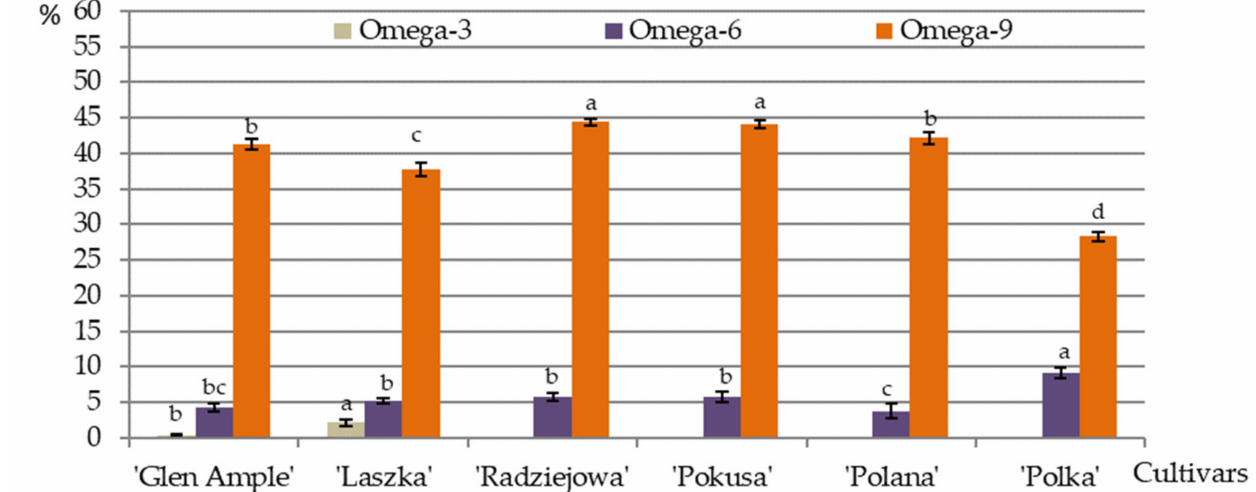
Figure 13. Percentage content of essential fatty acids in the pollen grains of six R. idaeus cultivars. Explanations: means followed by the same letter are not significantly different within the cultivar for the omega-3, omega-6, and omega-9 fatty acids at a significance level α = 0.05; (number of repetitions n = 3). Bars indicate standard deviation. Omega-3, total amount of α -linolenic acid (C18:3n3 alpha); Omega-6, total amount of linoleic acid (C18:2n6c), linoelaidic acid (C18:2n6t), cis -13,16-docosadienoic acid (C22:2n6); Omega-9, total amount of palmitoleic acid (C16:1n7), oleic acid (C18:1n9c), elaidic acid